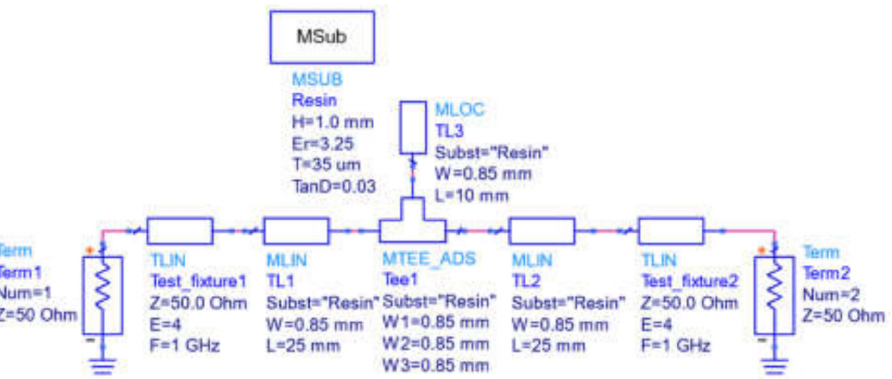
Figure 10. Circuit elements employed to simulate the response of the 10 mm long quarter wavelength open-ended stub calibrating network.